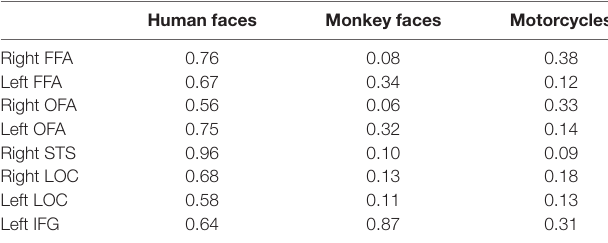
TABLE 1 | p -values from t -tests over the reaction times (RT) of the two conditions (low vs. high alpha power) per stimulus category. Human faces Monkey faces Motorcycles Right FFA 0.76 0.08 0.38 Left FFA 0.67 0.34 0.12 Right